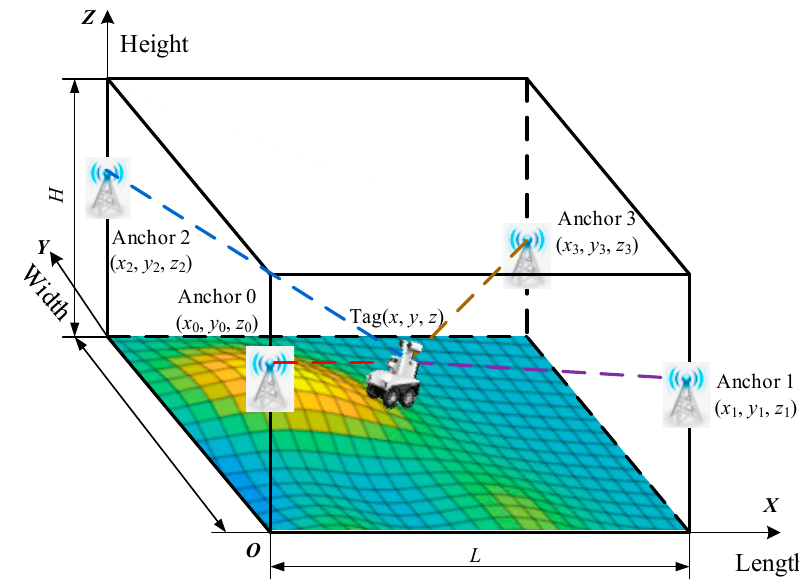
Figure 1. Schematic diagram of the principle of TOF-based UWB data